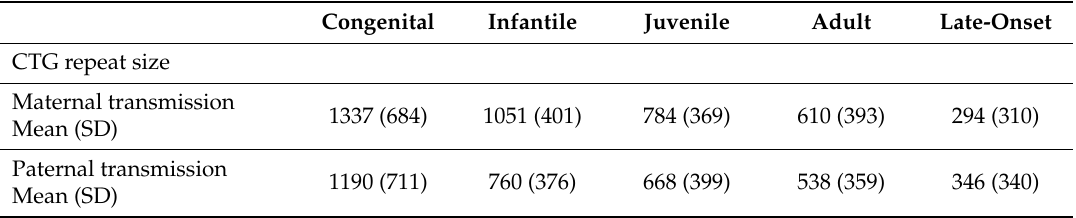
Table 1. Genetic characteristics of French DM1 cohorts [7]. SD = standard